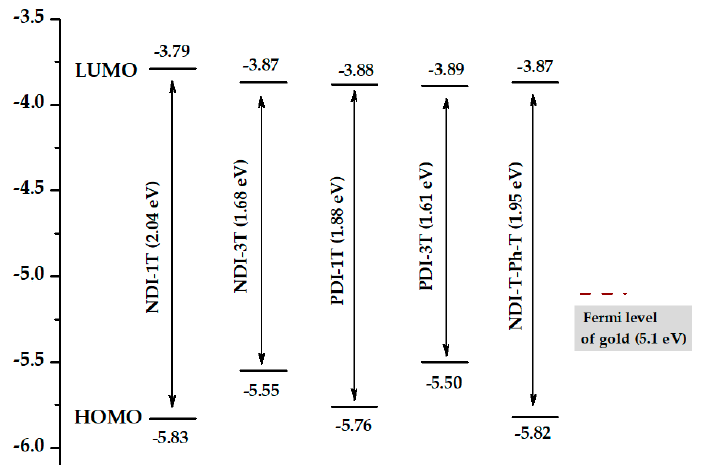
Figure 3. HOMO and LUMO energy levels for NDI-1T , NDI-3T , PDI-1T, PDI-3T and NDI-T-Ph-T semiconductors. Table 1. Electrochemical potentials versus SCE in CH 2 Cl 2 (referenced to Fc/Fc + couple) of NDI-1T , NDI-3T , PDI-1T , PDI-3T and NDI-T-Ph-T and frontier molecular orbital energy levels estimated from CV data.